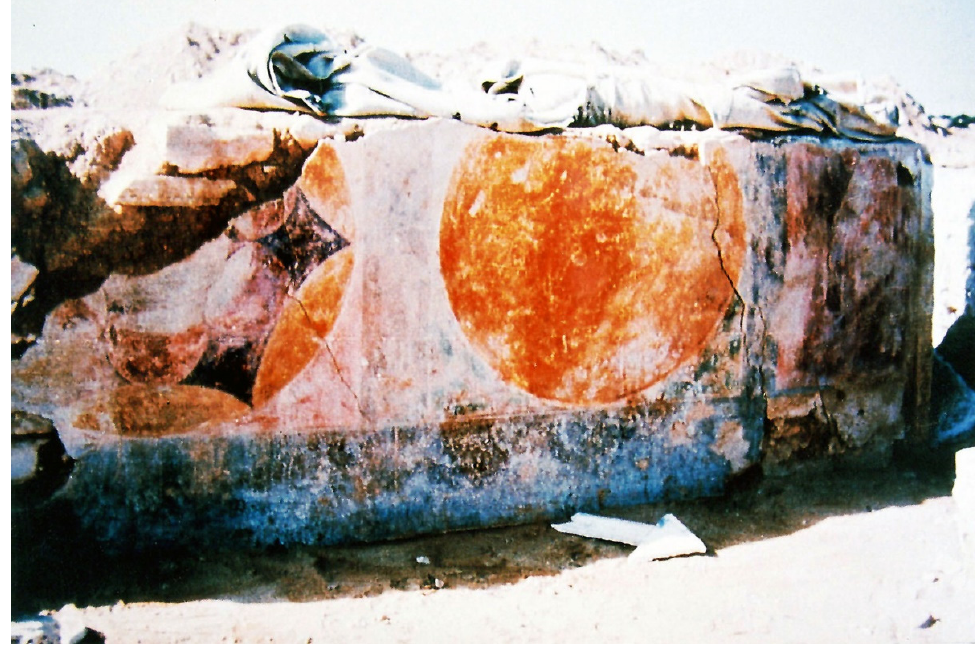
Figure 8. House H9, remains of the polychrome on the southern wall of the oikos of house H9 (photo Courtesy of Wiktor A. Daszewski; after Czerner 2009, Figure 75).